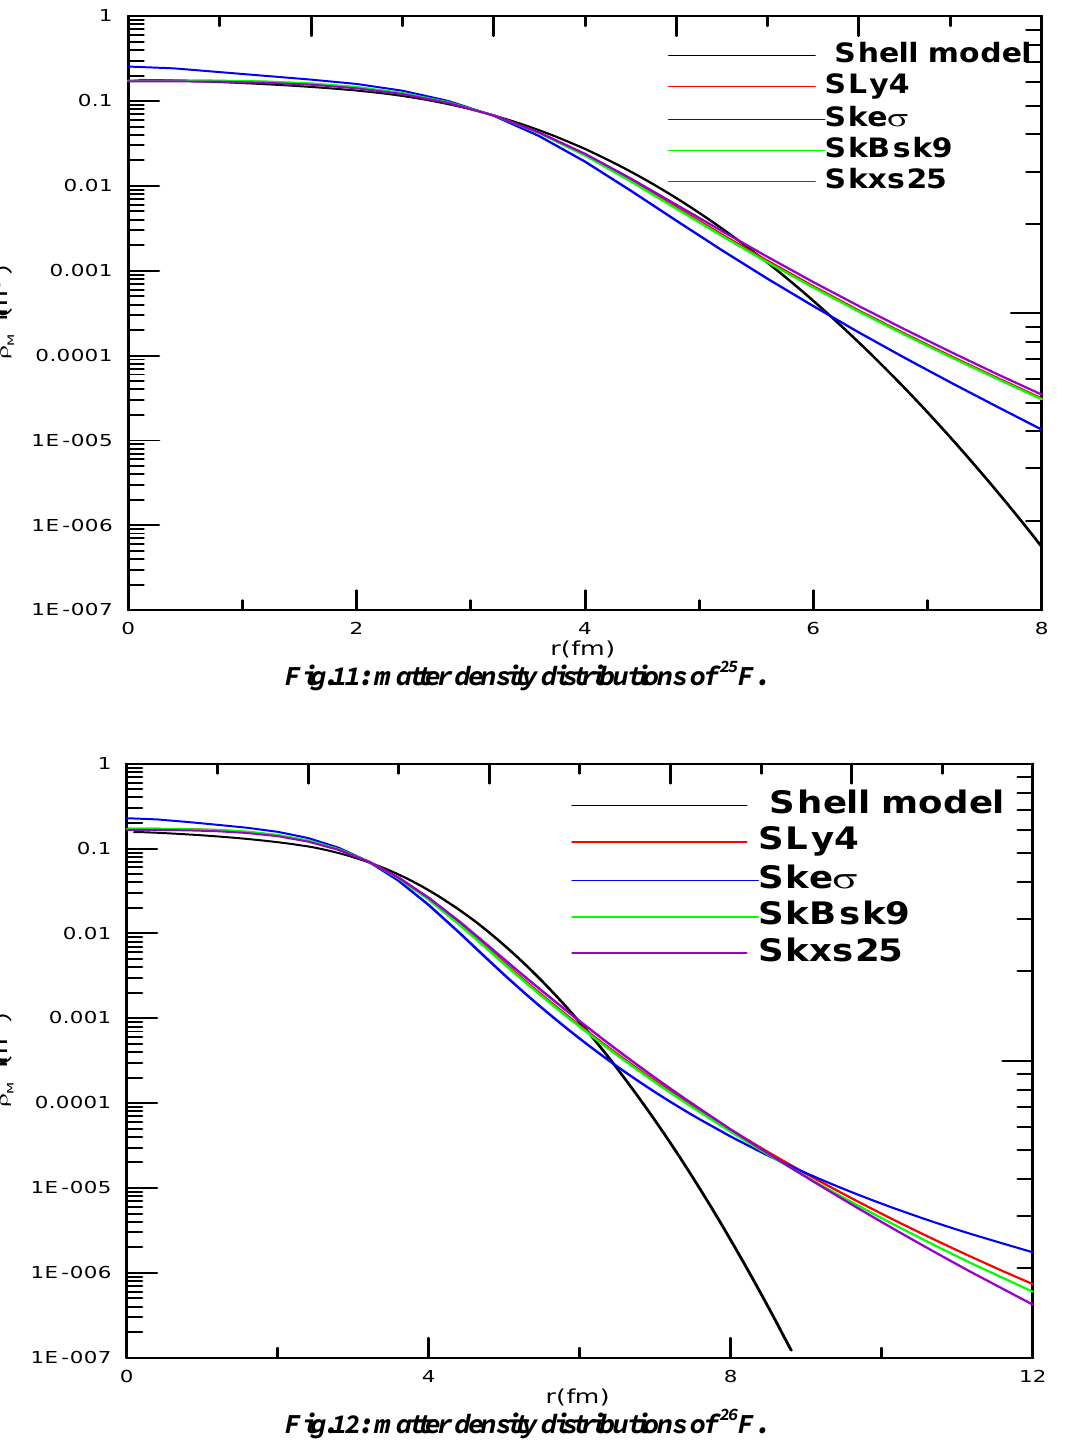
Fig.12: matter density distributions of 26